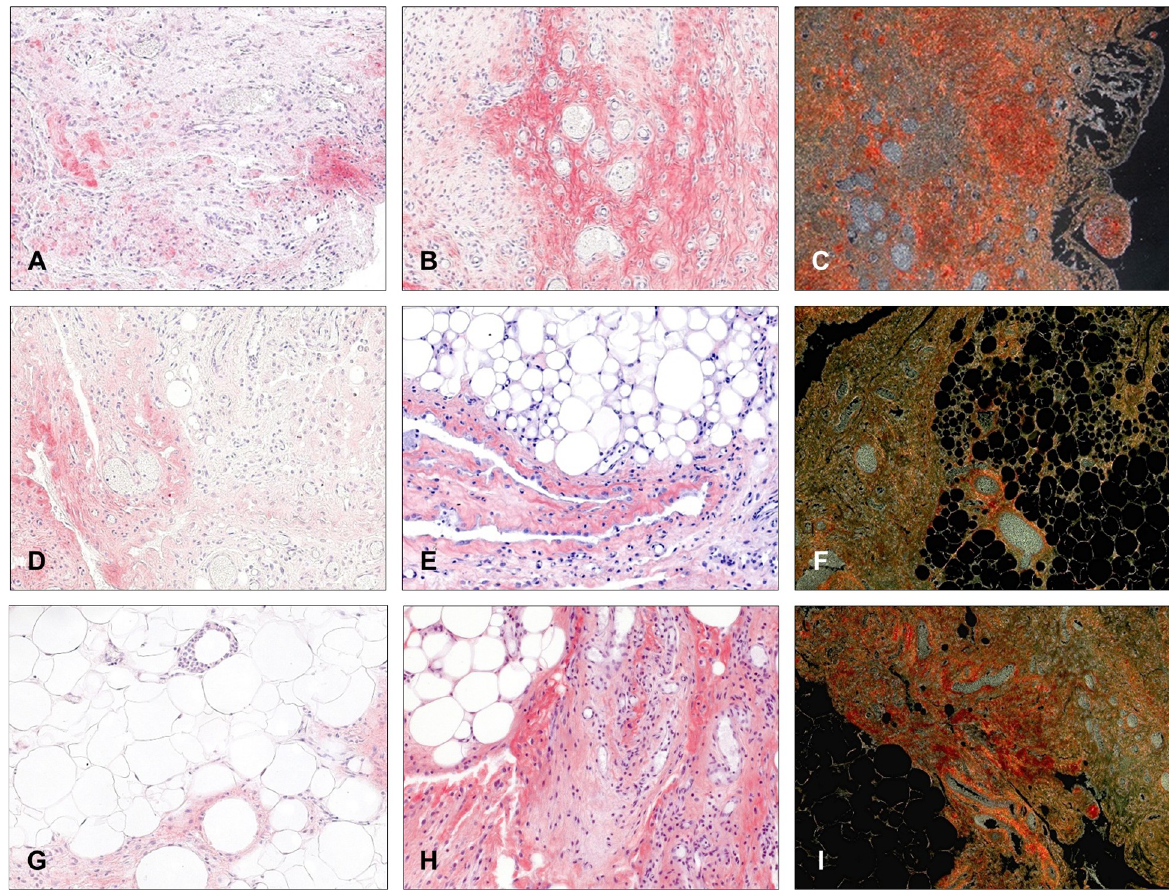
Fig 10. Collagen expression in adhesion tissue. Immunohistochemical labeling for collagen type I (A, D and G, 200x magnification), collagen type III (B, E and H, 200x magnification), and Picrosirius red staining (C, F and I, 100x magnification) in adhesion tissues from animals implanted with different meshes (A, B and C, Surgipro; D, E and F, DynaMesh; G, H and I,